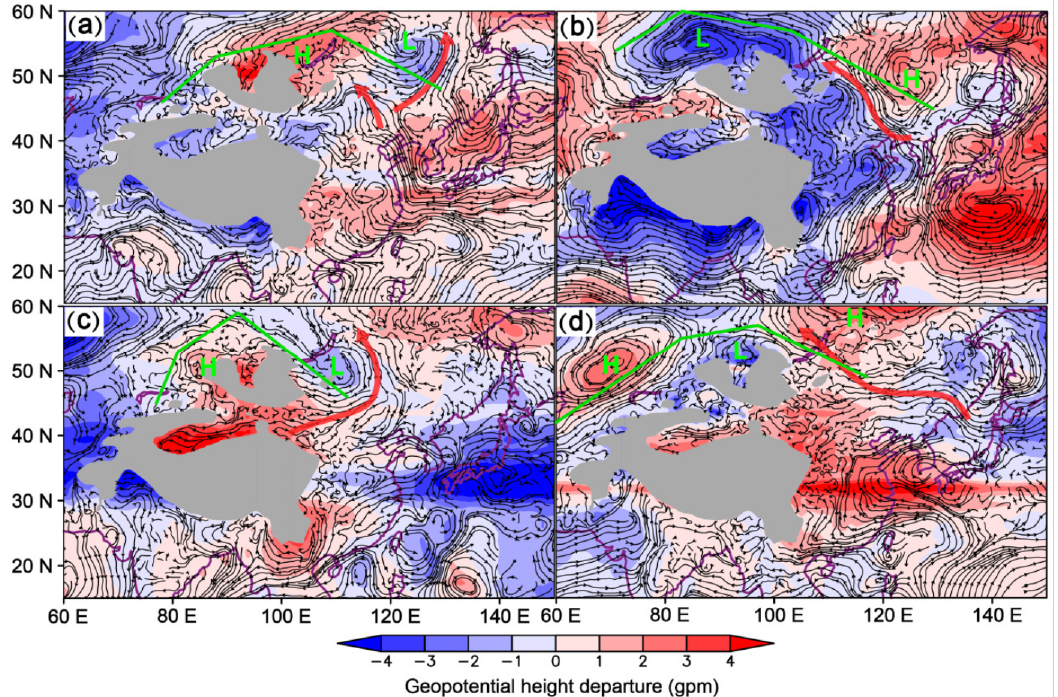
Figure 4. Longitudinal anomalies distribution of the differences between ECMWF-predicted and reanalyzed 850 hPa wind vectors (units: m · s − 1 ) and geopotential heights (shaded; units: gpm) for March ( a ), June ( b ), October ( c ), and December ( d ) averaged over the three years (2016–2018). The green curves in ( a – d ) are for the position along which the cross-section in Figure 6a–d is made. The red arrows mark the southerly branch that affects northern China. H and L stand for the centers of high and low geopotential heights, respectively. The Qinghai-Tibet Plateau and the Mongolian Plateau are